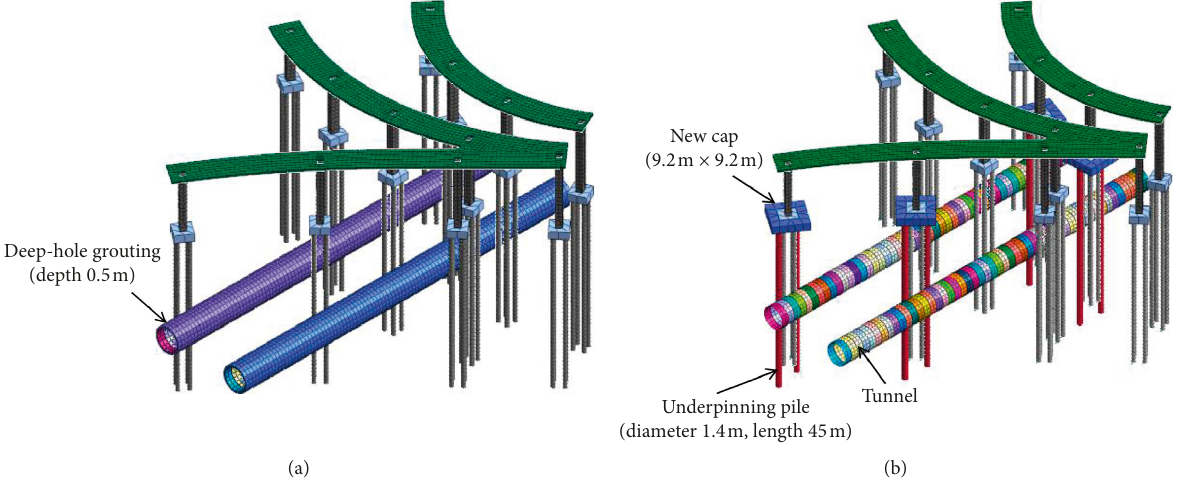
Figure 11: Three-dimensional finite element model: (a) deep-hole grouting; (b) pile foundation underpinning.